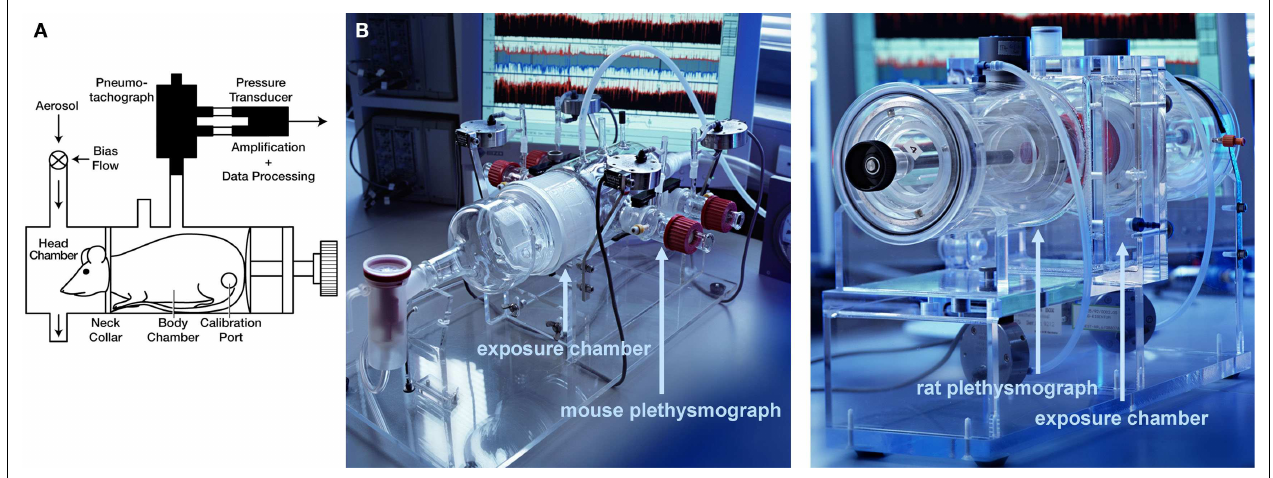
by means of pneumotachograph tube connected to a pressure transducer (see text for details). (B) Photos of head-out plethysmography systems for four mice (left) or four rats (right; only one of two systems